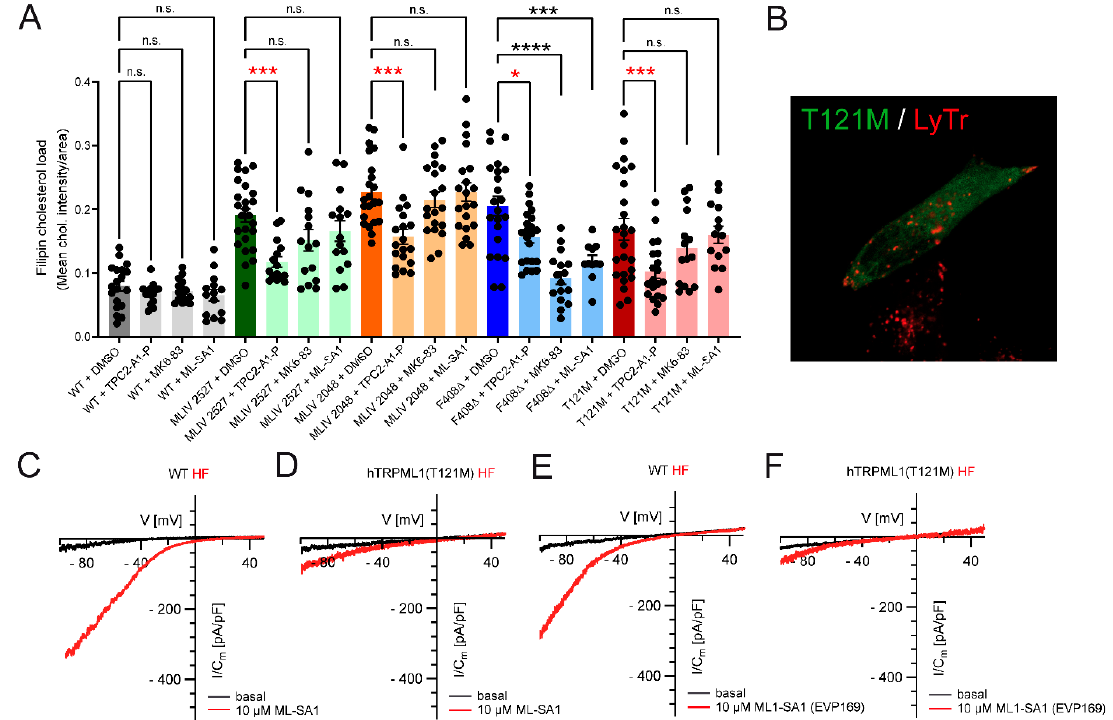
Figure 2. Effect of TPC2-A1-P on cholesterol accumulation in selected patient fibroblasts (HF) and electrophysiological characterization of a novel patient mutation (MCOLN1 T121M/T121M ). ( A ) Effect of TPC2-A1-P or the TRPML1 activators ML-SA1 and MK6-83 on cholesterol accumulation in WT, MLIV and selected patient fibroblasts, carrying MLIV-causing point mutations as indicated,